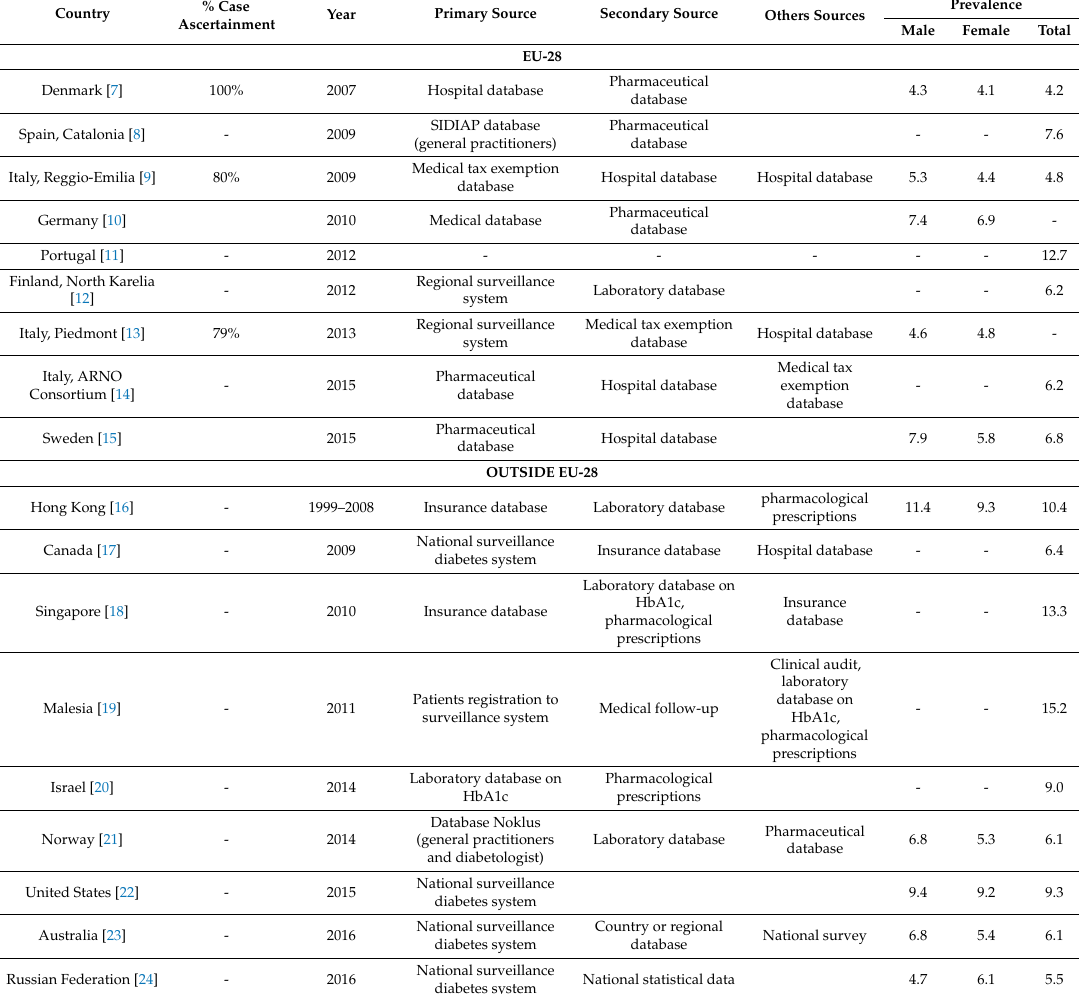
Table 2. Type 2 diabetes